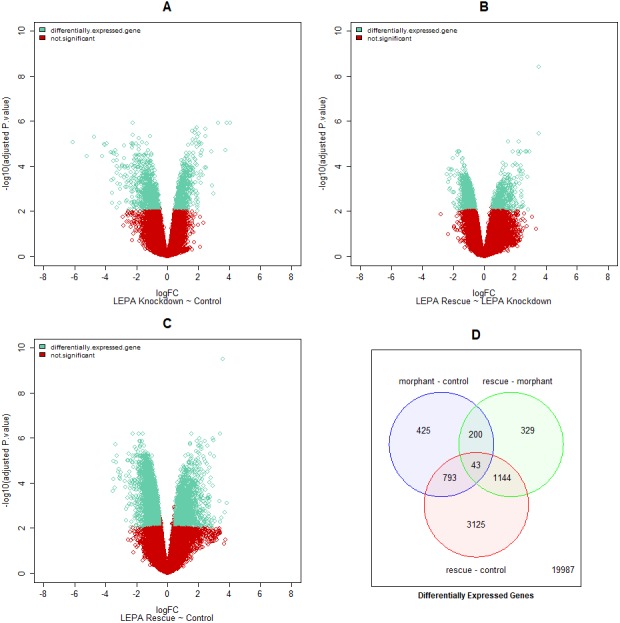
Differentially expressed genes for all datasets.Volcano plots (1A–1C) represent the adjusted p.value versus fold change for each gene across three pairwise comparisons (listed below each plot). Each point represents one gene. Differentially expressed genes are teal; red points denote genes that do not meet differentially expressed selection criteria. Venn diagram (1D) represents the number of differentially expressed genes (DEGs) in each comparison at adjusted p.value < 0.01 and log2 fold change ≤0.5 or >0.5. “morphant–control” refers to genes that are differentially expressed in lepa knockdown zebrafish compared to uninjected controls. “rescue–morphant” refers to genes that are differentially expressed in lepa rescue zebrafish compared to lepa knockdown. “rescue–control” refers to genes that are differentially expressed in lepa rescue zebrafish compared to uninjected controls.